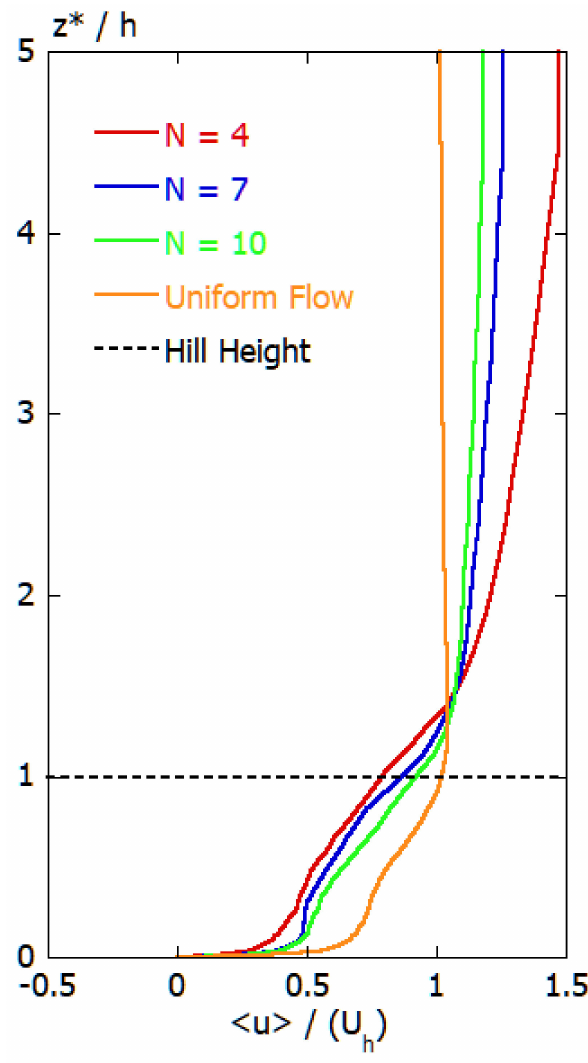
Figure 16. Comparison of a time-averaged U-velocities at a measurement station (x = 10 h) behind the gentle hill under neutral